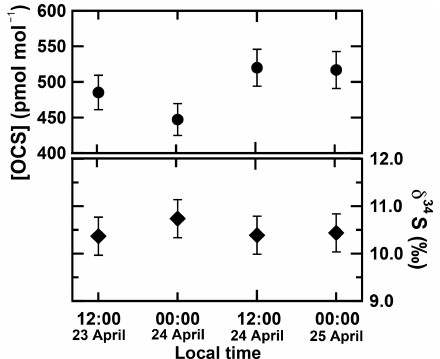
Figure 6. OCS concentrations and δ 34 S(OCS) values for atmo- spheric samples collected at the Suzukakedai campus of the Tokyo Institute of Technology located in Yokohama, Japan. The error bar is 6% for OCS concentration based on the precisions of syringe injection and flow rate of the diaphragm pump in the sampling sys- tem. The precision of δ 34 S is estimated from a 1 σ uncertainty of 0.4‰.